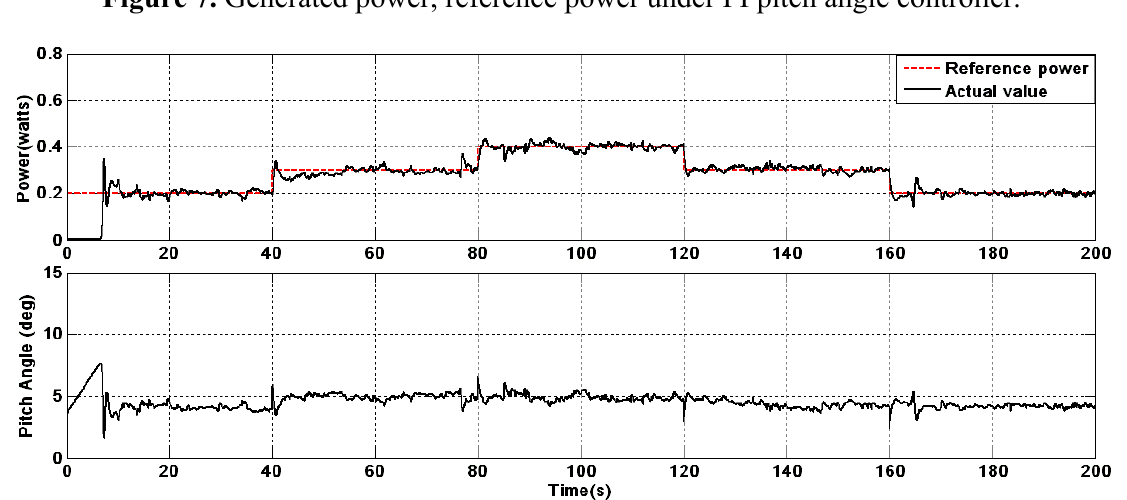
Figure 7. Generated power, reference power under PI pitch angle controller.